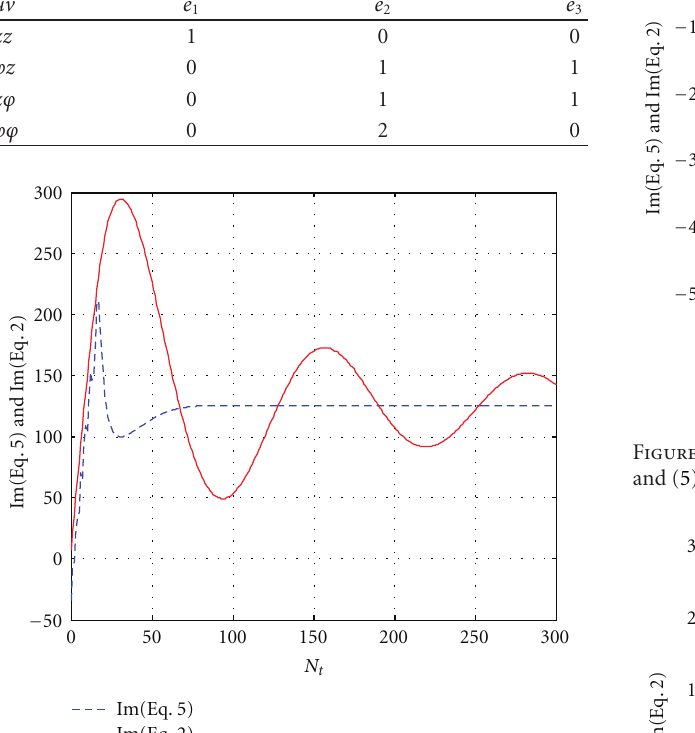
imaginary part versus N t using (2) zz